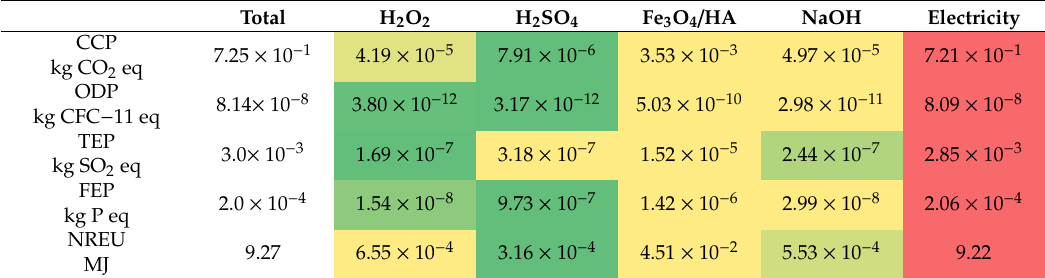
Table 3. Impact at the midpoint level for the degradation process of 90% of 20 µ M BPA in 1 L of water in the presence of Fe 3 O 4 / HA (100 mg / L) and hydrogen peroxide (1 mM) at pH